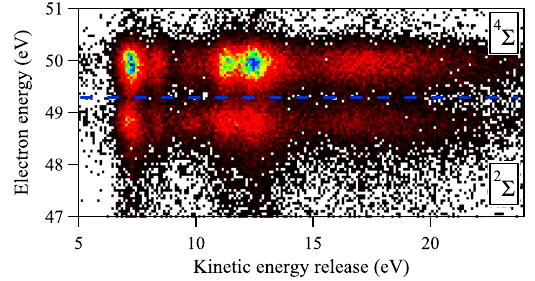
Figure 4. The correlation between the electron kinetic energy and the kinetic energy release of O + /O + ion pair. The region above the blue dashed line contains decays from the